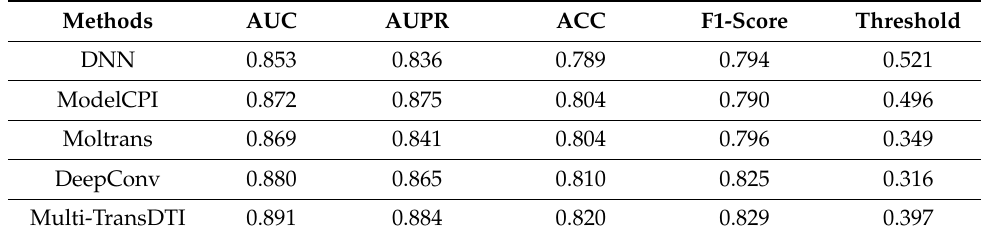
Table 4. Comprehensive performance of different models on 50% BindingDB.